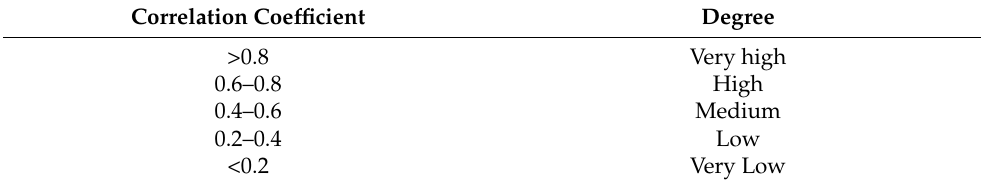
Table 6. Correlation